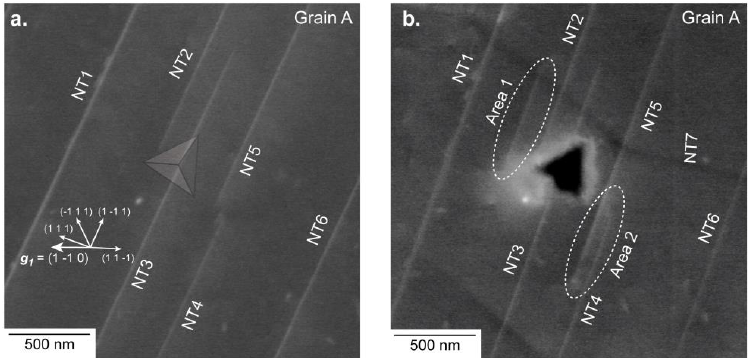
Figure 2. Region of interest 1 (ROI1) for which the surface is close to ( 4 5 7 ) . ( a ) Accurate electron channeling contrast imaging (aECCI) obtained with g = ( 1 1 ̅ 0 ) showing six [ 1 1 2 ̅]( 1 1 1 ) Nano-Twins (NTs) and the position of the imprint (transparent Berkovich imprint). The white arrows indicate the trace of the { 111 } planes. ( b ) Enhanced BSE image showing the 500 µN indent. Two areas (labelled Areas 1 and 2) have changed. The NT7 slightly visible in (b) comes from a neighbor imprint.